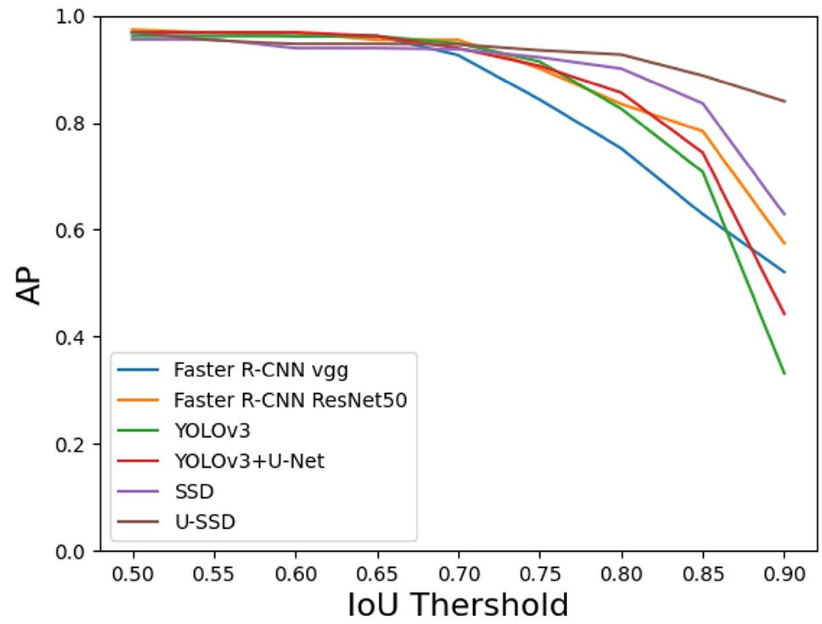
Figure 8. The average precision from IoU = 0.5 to IoU = 0.9 on our